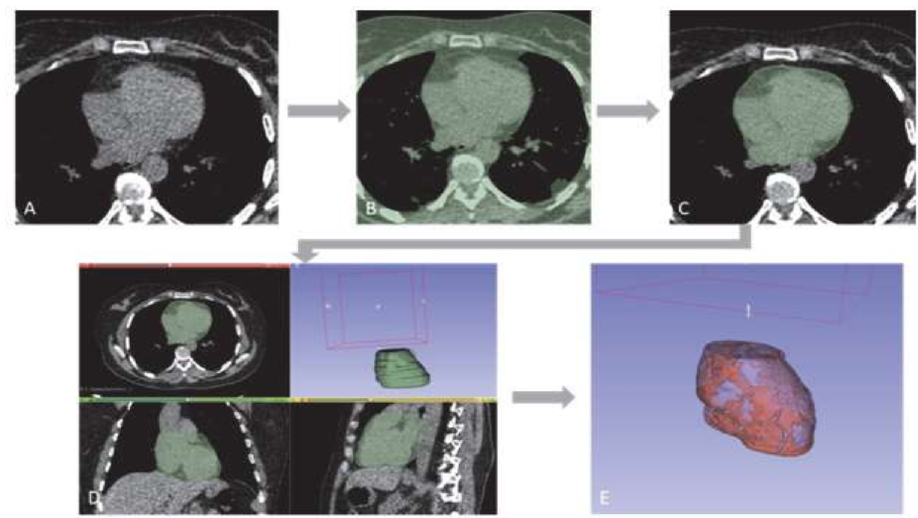
Figure 2. Example of manual segmentation of the Peri and EAT volumes in the LDCT. ( A ) LDCT axial image on mediastinal window; ( B ) mediastinal thresholding to exclude pulmonary parenchyma; ( C ) intrapericardial segmentation slice by slice using painting and erasing tools; ( D ) obtained 3D in- trapericardial volume (Peri); ( E ) Obtained 3D EAT volume after standard fat attenuation